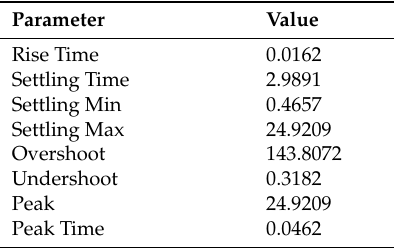
Table 6. Characteristics of the motor torque curve without using the correction method.